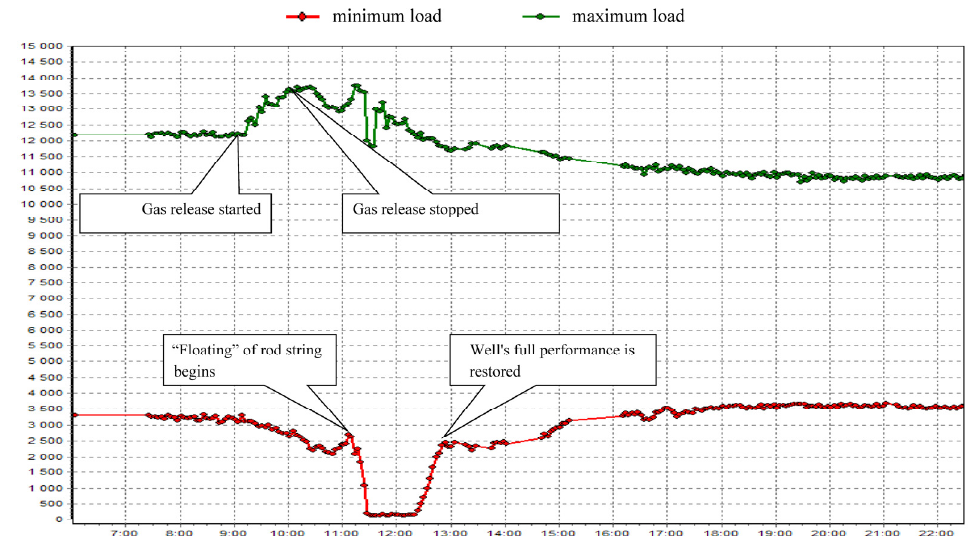
Figure 4. Trends of maximum and minimum loads on the sucker-rod string at the well No. 32554 during the experiment.